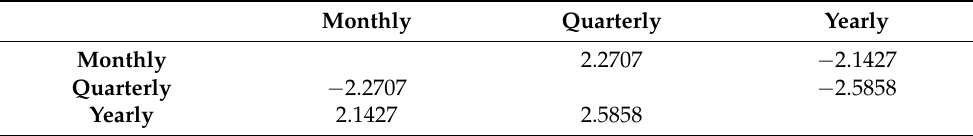
Table 5. Diebold and Mariano test with heteroscedasticity correction.